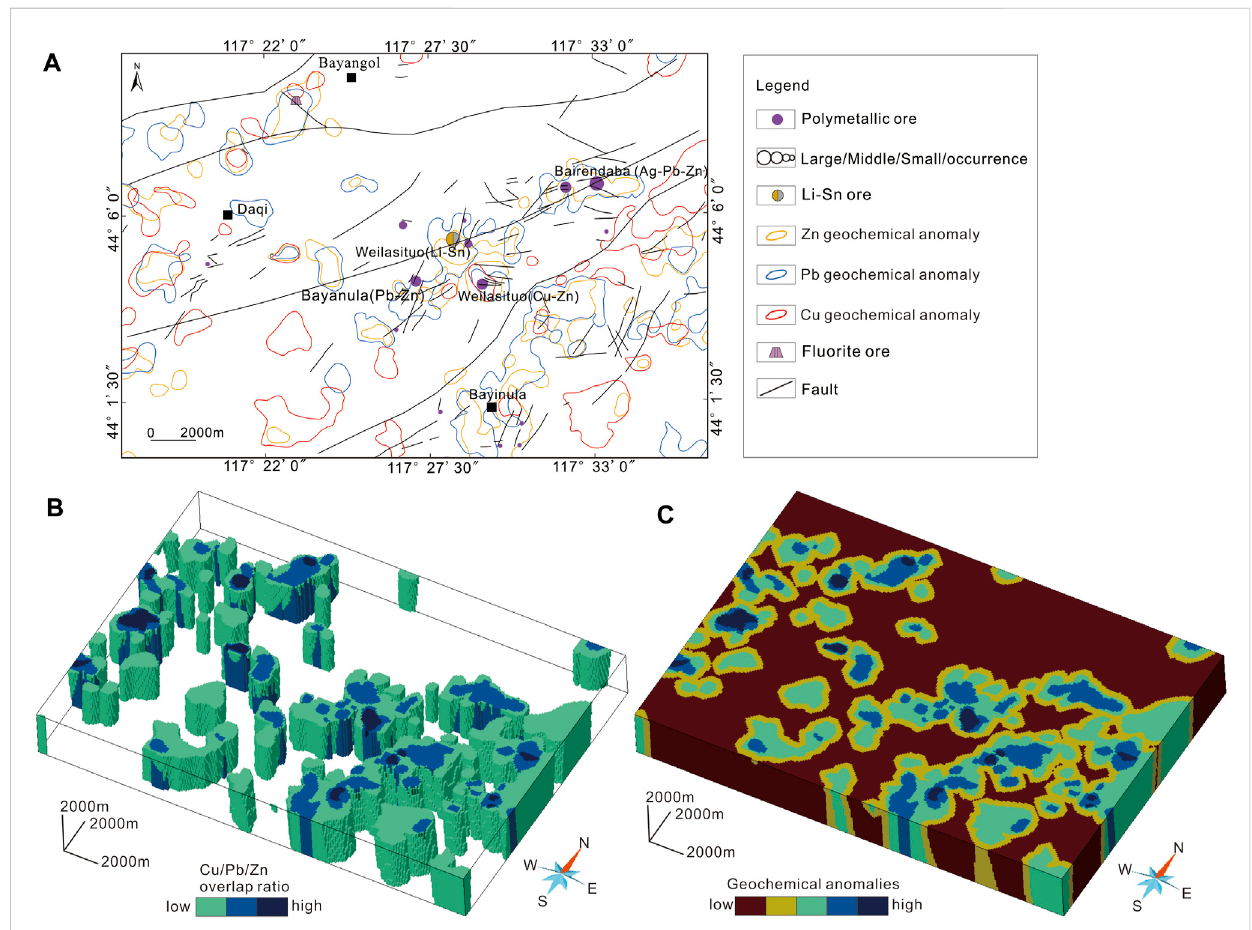
FIGURE 9 Geochemicalanomalymodelof (A) thegeochemicalanomalydistributionmap; (B) the3Dgeochemicalanomaly(Cu,Pb,Zn)overlapratiomodel (C) the 3D geochemical anomaly